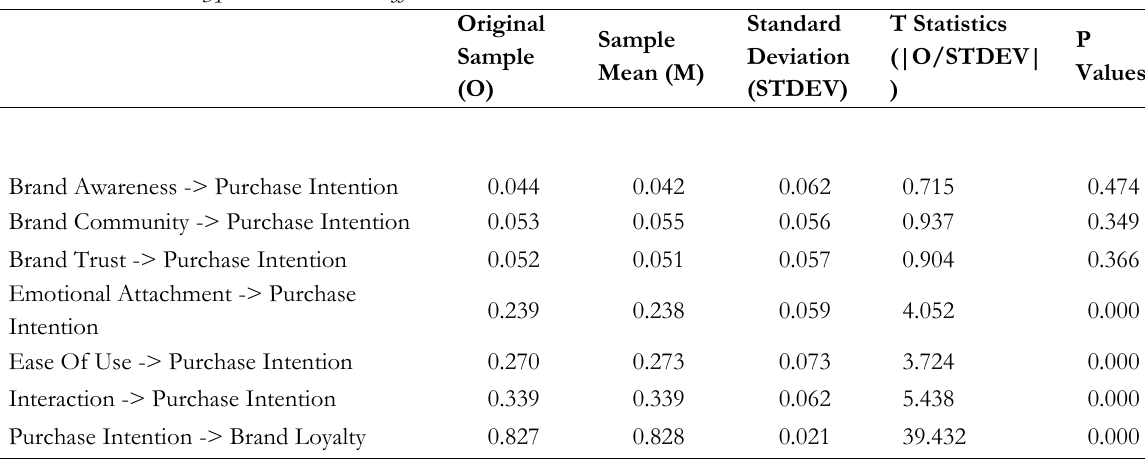
Table 6: Hypothesis-Path